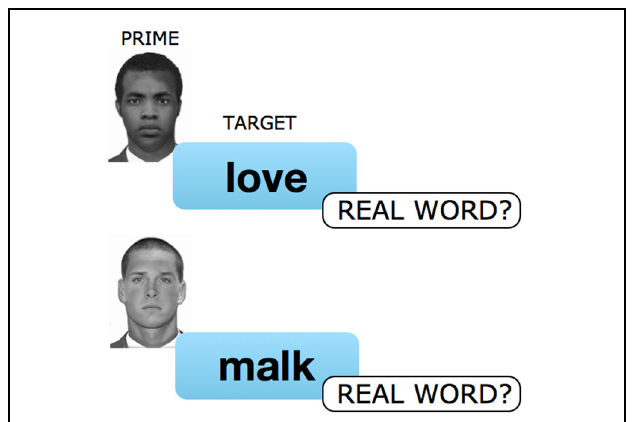
FIGURE 2 | ALPS (Affective Lexical Priming Score). On each trial participants were initially presented with either a black or white face image prime displayed for 250ms. Following a 200ms inter-stimulus interval (ISI), a letter-string was presented that was either a real word or a non-sense word. Participants were instructed to decide whether the letter-string was a real word or a non-sense word (i.e., they were naïve to the true goals of the experiment). The real words were positive (e.g., “love”), negative (e.g., “hate”), or neutral (e.g., “tree”). Each letter-string remained on the screen until the participant responded word/non-word using one of two computer keys.